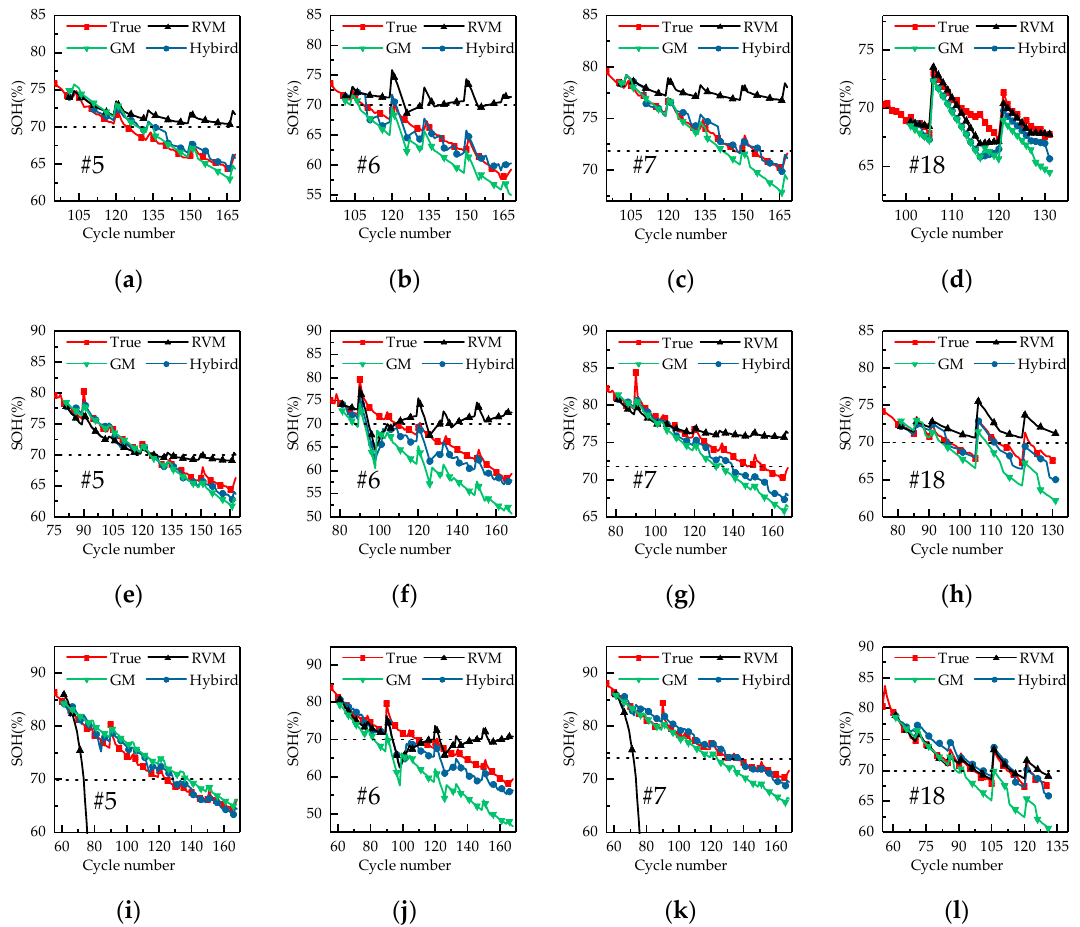
Figure 7. Prediction results at different started prediction cycles of different batteries. ( a ) Started prediction at cycle 100 of battery #5, ( b ) Started prediction at cycle 100 of battery #6, ( c ) Started prediction at cycle 100 of battery #7, ( d ) Started prediction at cycle 100 of battery #18, ( e ) Started prediction at cycle 80 of battery #5, ( f ) Started prediction at cycle 80 of battery #6, ( g ) Started prediction at cycle 80 of battery #7, ( h ) Started prediction at cycle 80 of battery #18, ( i ) Started prediction at cycle 60 of battery #5, ( j ) Started prediction at cycle 60 of battery #6, ( k ) Started prediction at cycle 60 of battery #7, ( l ) Started prediction at cycle 60 of battery #18. Table 1. Comparison of prediction results of the hybrid method with the relevance vector machine ( RVM) and the gray model (GM).